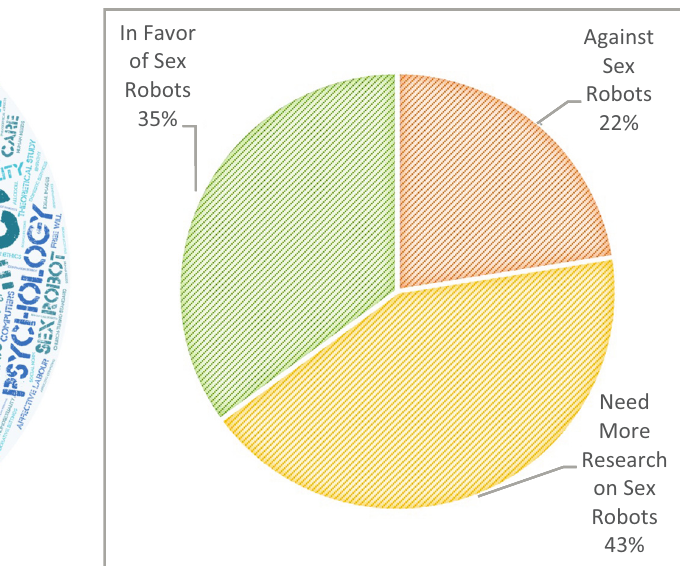
Figure 3: Word cloud of sex robot key words ( Scopus ) . Figure 4: Sex robot - coded author coalitions ( Scopus )